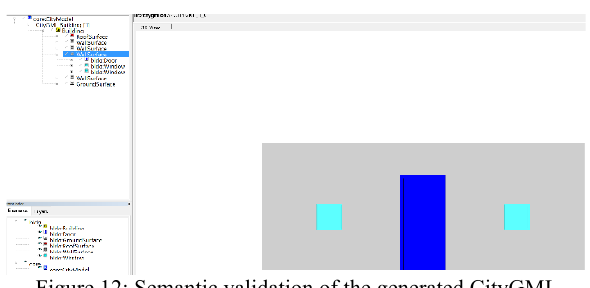
Figure 12: Semantic validation of the generated CityGML Model